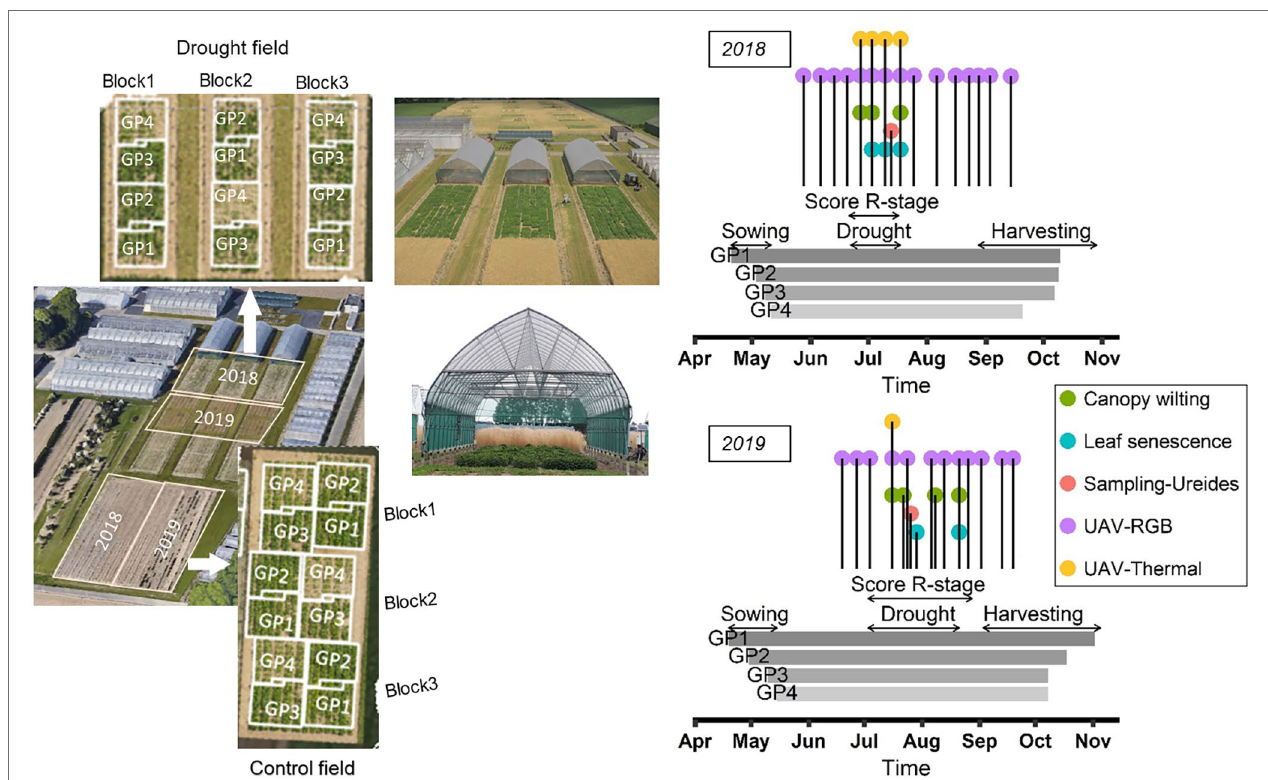
FIGURE 1 | Field plans and timing of the observations. Left: layout of control and drought fields in 2018 and 2019, and general view of the rain-out shelters. Right: schematic representation of the timing of the observations performed in 2018 and 2019. Horizontal arrows delineate the following periods: sowing, determination of R-stage, drought treatment and harvesting. Vertical lines indicate the moments when canopy wilting and leaf senescence were scored, when samples were taken for the determination of ureides concentration, and the timing of the RGB and thermal UAV